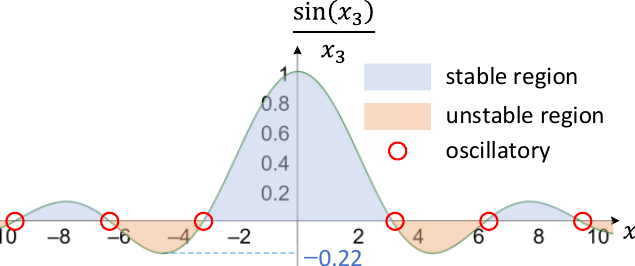
Figure 5. Graphical representation of the stable region of the dynamic characteristic equation, g 4 ( t ) + 2 g 3 ( t ) + ( 3 + ψ ( t )) g 2 ( t ) + ( 2 + ψ ( t )) g ( t ) + ψ ( t ) = 0. For simplicity of graphical representa- tion, a specific time t is applied for ψ ( t ) .